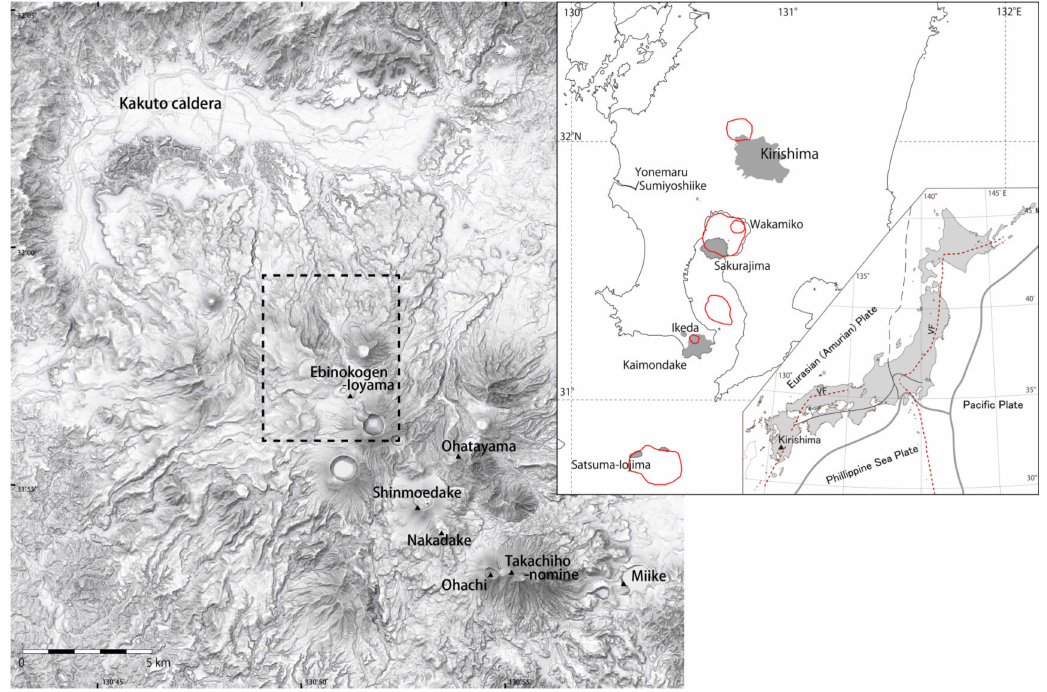
Figure 1. Geographic map of Kirishima Volcano Group. Dashed box shows the map of the study area in Figure 2. The base map with Kashimir3D [39]. In the upper right corner, the red circles denote the calderas while the gray areas indicate active volcanoes. VF: Volcanic